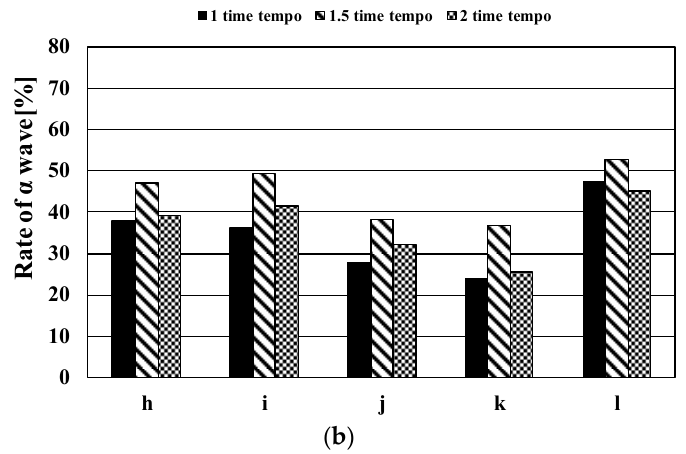
Figure 13. Experimental results for brain wave appearance rate of different noise condition using driving simulator. ( a ) α wave appearance rate that participants felt relax when listened to music of 1-time or 2-time tempo; ( b ) α wave appearance rate that participants felt relax when listened to music of 1.5-time tempo.